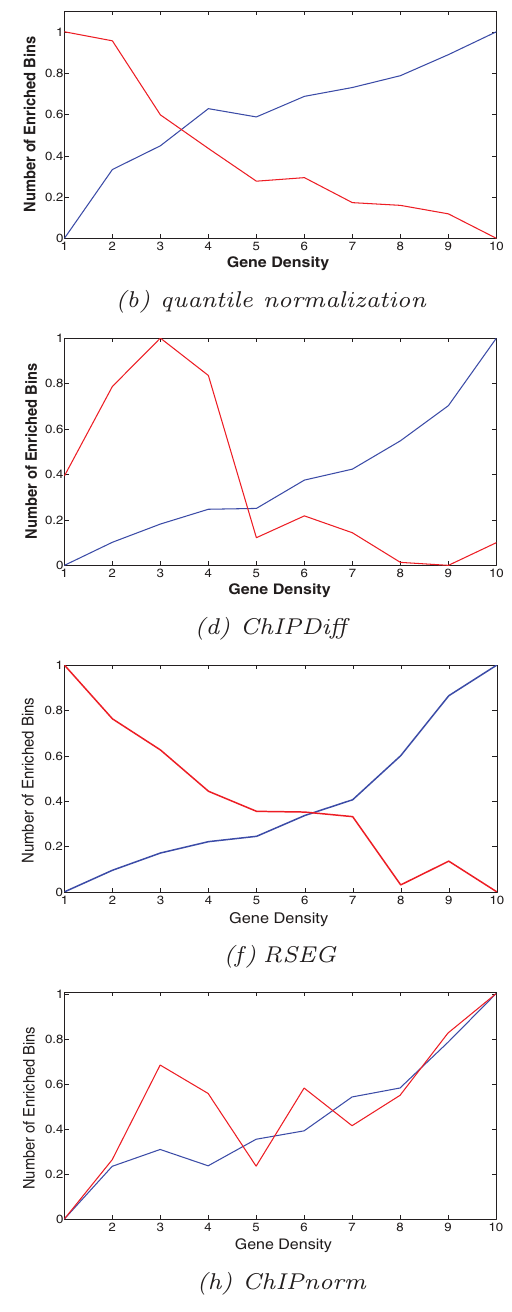
Figure 6. Enriched bins with respect to gene density in 1 Mbp region. The plots are normalized. x axis 1 to 10 indicates lowest to highest gene density, while y axis 0 to 1 indicates minimum to maximum average number of differentially enriched bins for both ES and NP cells. Blue line indicates ES differentially enriched bins and red line indicates NP differentially enriched bins. The number of enriched bins per 1 Mbp should increase with gene density. doi:10.1371/journal.pone.0039573.g006 order. The actual values of these five thresholds for each method is given in the supplementary material (Supporting Information S1).